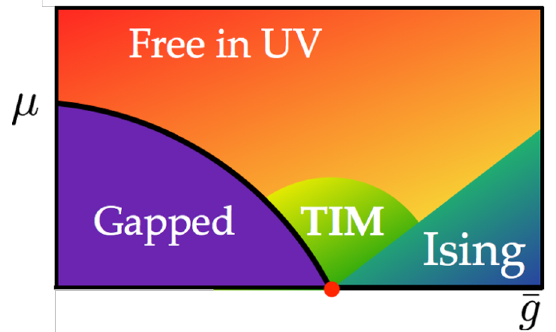
Figure 1 . Cartoon of the phase diagram of SGNY, as a function of the dimensionless parameter g and energy scale µ . The thick solid line indicates the gap, while the color gradients indicate RG flows between different regimes. A more precise version of this diagram obtained from our numerical results, with a similar color scheme, is exhibited in figure